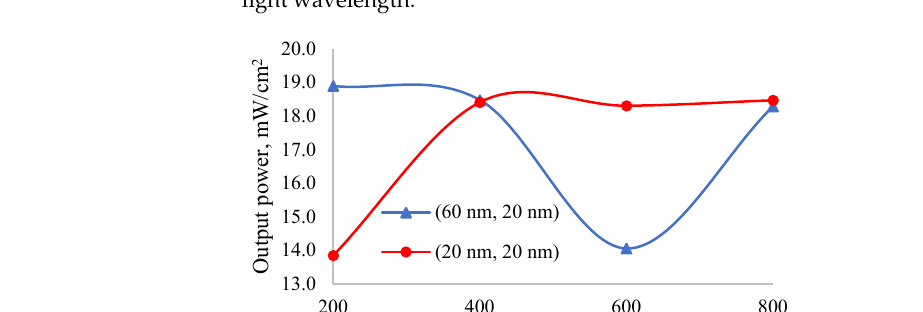
Figure 8. Dependence of the absorption ( a ) and reflection ( b ) coefficients of the solar cells with the lowest (200 nm, 20 nm, and 20 nm) and highest (200 nm, 60 nm, and 20 nm) output power on the light wavelength.